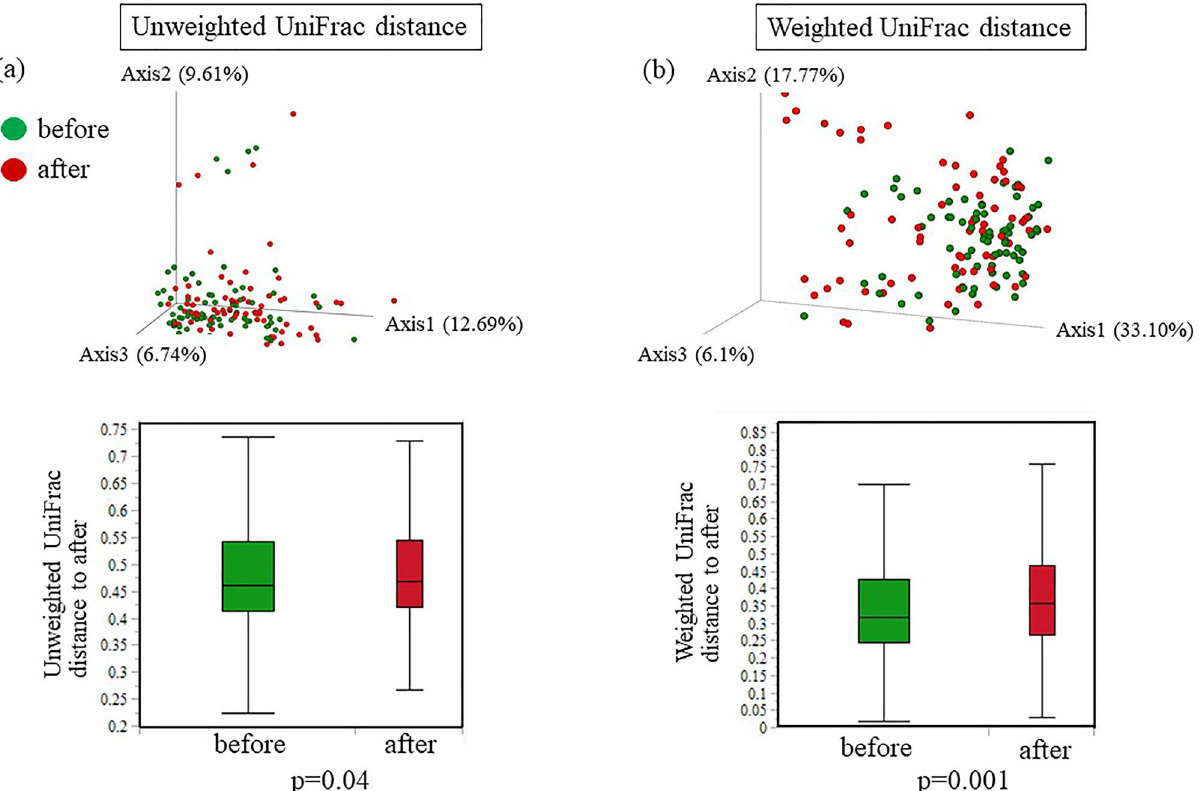
Figure 5. Beta diversity of the gastric microbiota before and after distal gastrectomy (DG). ( a ) Unweighted UniFrac distances. ( b ) Weighted UniFrac distances. Principal coordinate analysis plot for samples before and after DG. Box plots represent UniFrac distances of the before and after groups relative to the after group, p < 0.05; comparison between groups using a permutational multivariate analysis of variance (999